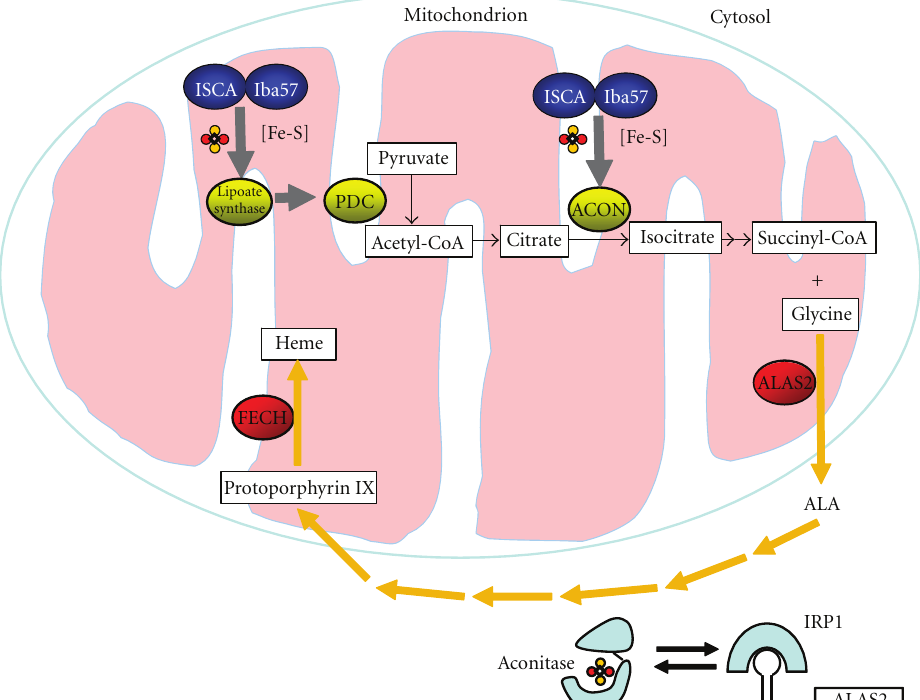
Figure 1: The Fe-S biogenesis proteins, ISCA and C1orf69 (Iba57 homologue), may impact heme synthesis by a ff ecting the production of succinyl-CoA, a substrate of heme synthesis. This proposed role is highly hypothetical and has not been shown in organisms that perform erythropoiesis. The ISCA- C1orf69 complex provides Fe-S clusters for lipoate synthase as suggested in yeast [63], which produces lipoate for a subunit of the pyruvate dehydrogenase complex (PDC). PDC converts pyruvate into acetyl-CoA, which enters the citric acid cycle to form citrate. The ISCA- C1orf69 complex provides the Fe-S cluster for mitochondrial aconitase, which converts citrate to isocitrate, which leads to synthesis of succinyl-CoA, a substrate for the first step in heme biosynthesis. All proteins are in the matrix. Other Fe-S proteins important in heme biosynthesis are ferrochelatase, which is unstable without its [2Fe-2S] cluster, and IRP1, which represses synthesis of ALAS2 when it lacks an Fe-S cluster. In the heme synthesis pathway, succinyl-CoA and glycine are condensed into 5-aminolevulinic acid (ALA). The subsequent six steps take place either in cytosol or in the intermembrane space of mitochondria. The last step is the insertion of a ferrous iron into protoporphyrin IX by ferrochelatase (FECH) to result in heme